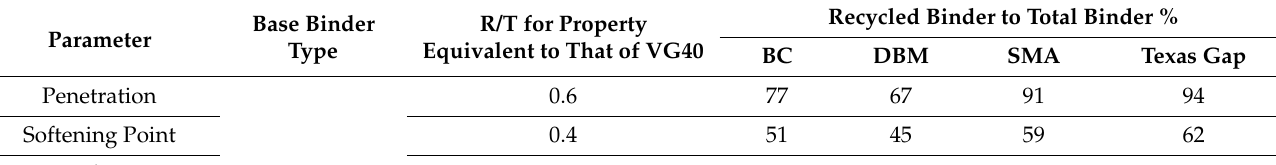
Table 11. R/T Ratios at Which Property of Blend is Similar to That of